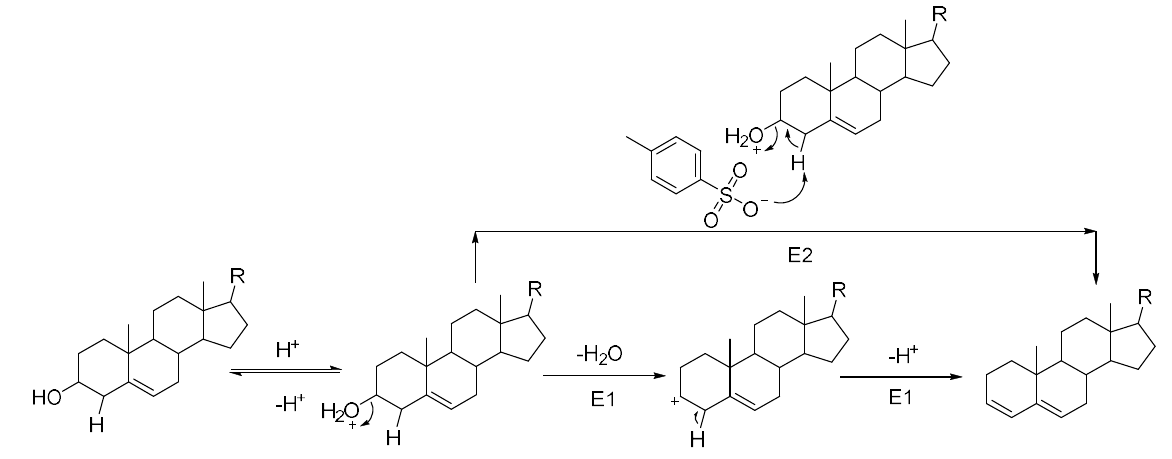
Figure 7. Reaction mechanism of sterol dehydration.